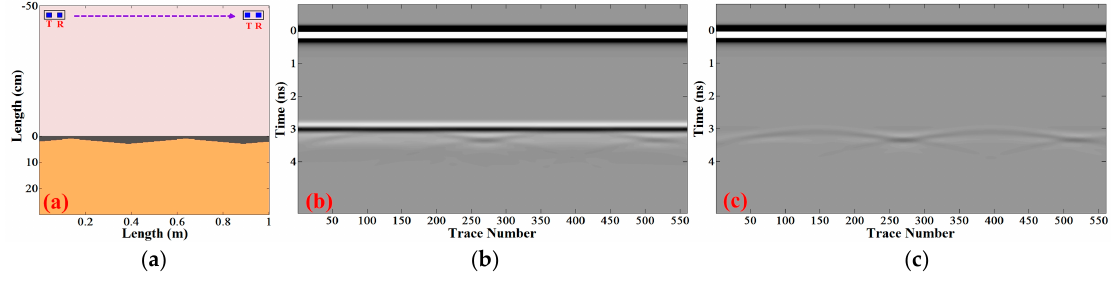
Figure 4. ( a ) The model for the horizontal high-pass filtering; ( b ) the simulated GPR signals; ( c ) the processed GPR signals after horizontal high-pass filtering. ( c ) the processed GPR signals after horizontal high-pass